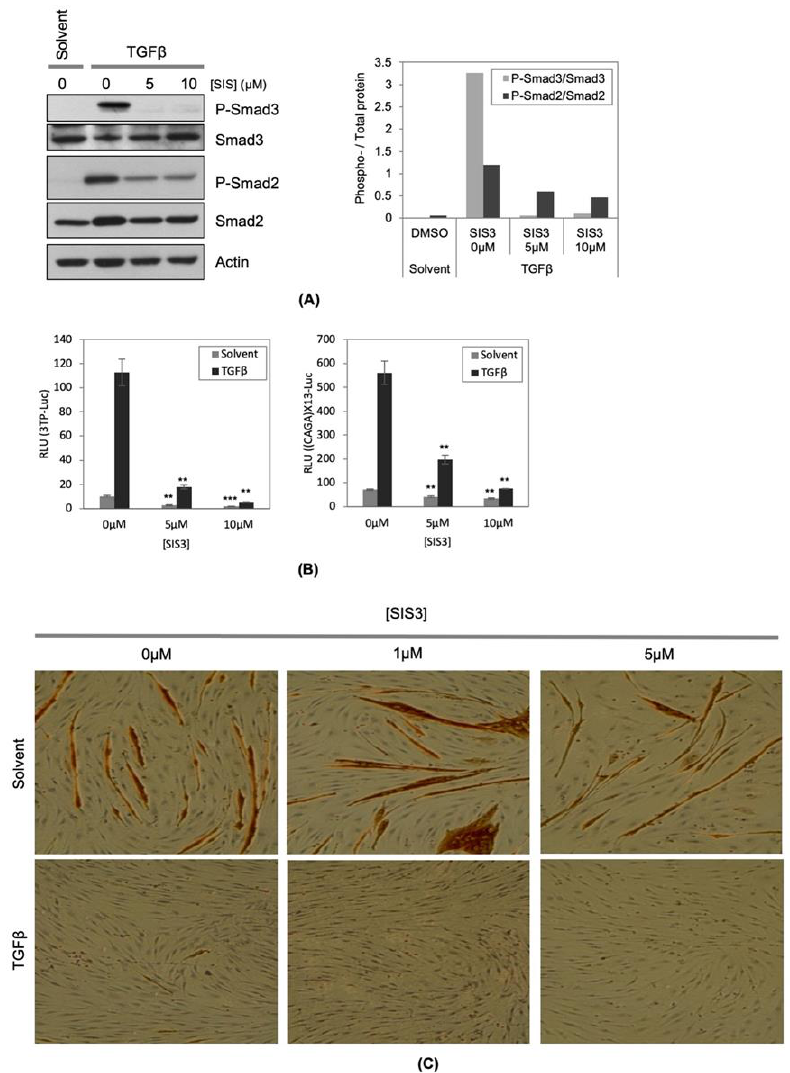
Figure 1. Inhibition of transforming growth factor β (TGF β ) mediated Smad3 phosphorylation does not reverse the inhibitory e ff ect of TGF β on muscle di ff erentiation. ( A ) C2C12 cells were seeded onto cell culture plates at equal density and maintained in TGFβ (1ng/mL) with or without indicated concentrations of SIS3. Total protein samples were extracted from the cells and equal amounts of total protein (20μg) were subjected to Western blotting analysis. The levels of indicated proteins were assessed by a standard immuno-blotting technique with a specific primary antibody. Actin indicates equal amounts of protein loading into each lane (left panel). Quantification of the band intensity of the P-Smad2 and P-Smad3, and total Smad2 and Smad3 in the left panel were measured by ImageJ, and the ratios of the band intensity of the phospho- to the corresponding total-protein band were graphed (right panel). ( B ) C2C12 cells were transfected with either 3TP-lux (left panel) or (CAGA)X13-luciferase reporter gene construct (right panel), and to monitor transfection e ffi ciency, pCMV- β -gal construct was included in each condition. The transfected cells were maintained for 16 h in TGF β (1ng / mL) with or without indicated concentrations of SIS3. Total protein samples were harvested with a luciferase lysis bu ff er. Luciferase activity (RLU: relative luciferase unit) in each condition was measured independently and normalized according to β -galactosidase activity. ( n = 3, +/ - SD). The p -value was calculated relative to the control by two tailed T-Test (** p < 1X10 − 3 , *** p < 1X10 − 5 ). ( C ) C2C12 cells were seeded onto cell culture plates at equal density and maintained in TGF β (1ng / mL) with or without indicated concentrations of SIS3 for 48 h. The cells were fixed and stained for muscle myosin heavy chain (MyHC) detection by immunochemistry. The photomicrographs are representative fields in each